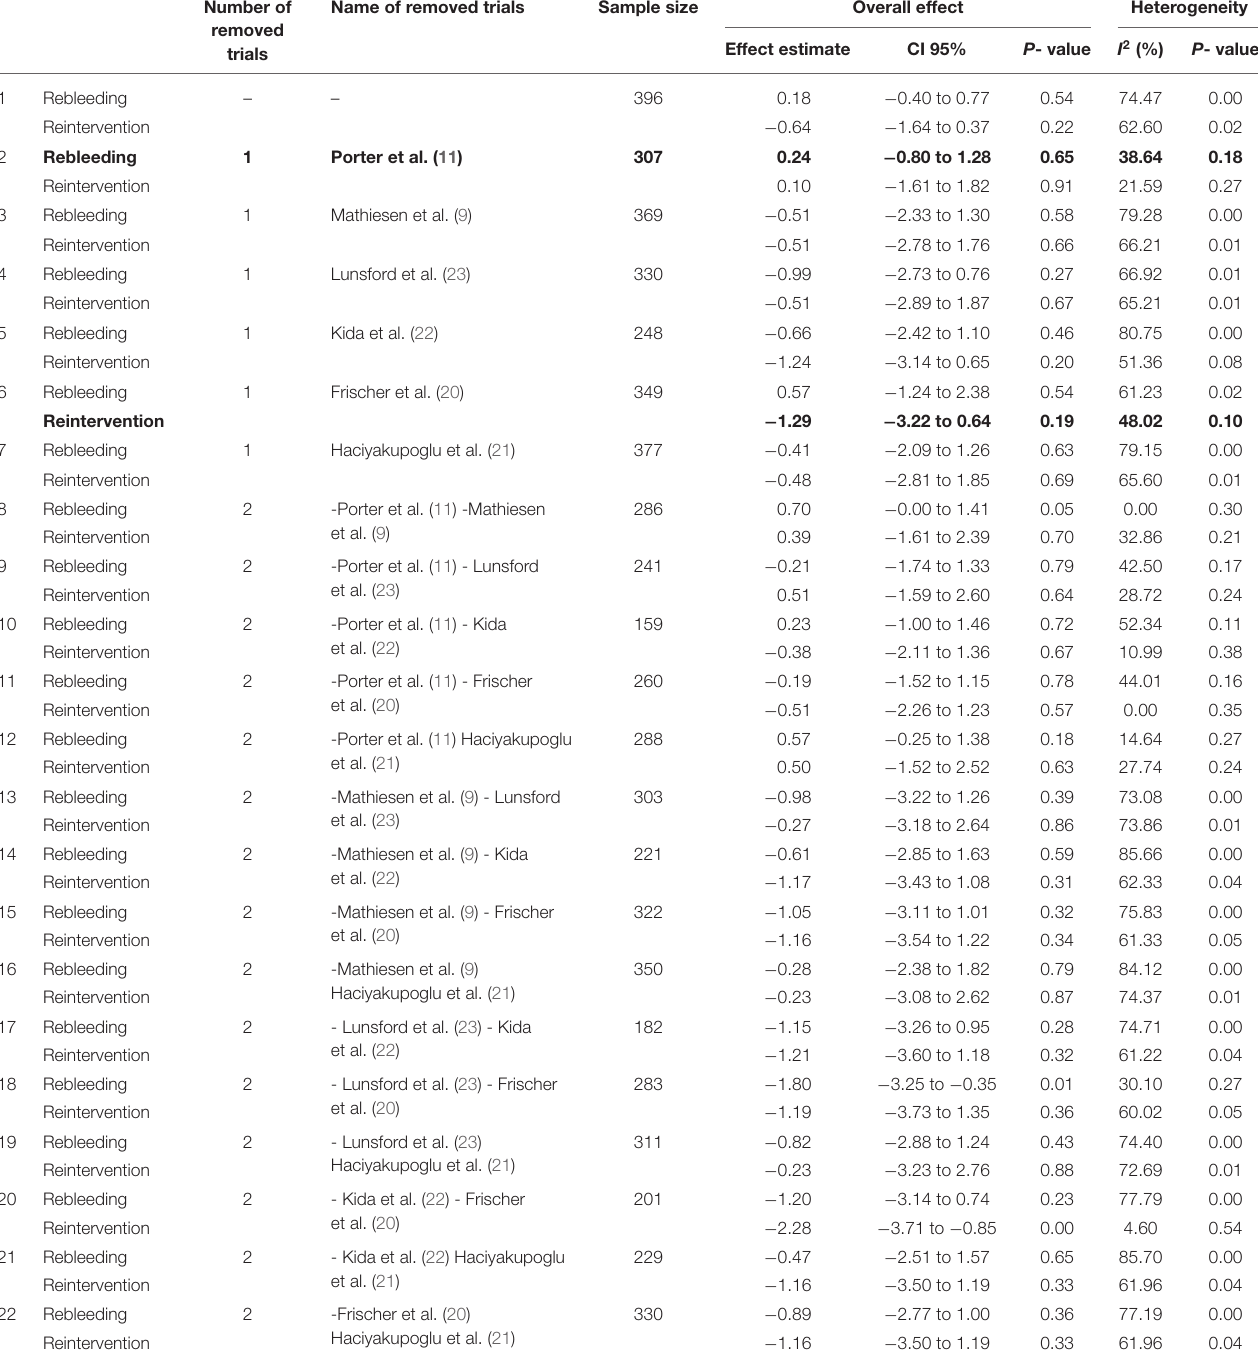
TABLE 4 | Statistical characteristics from leave-one-out